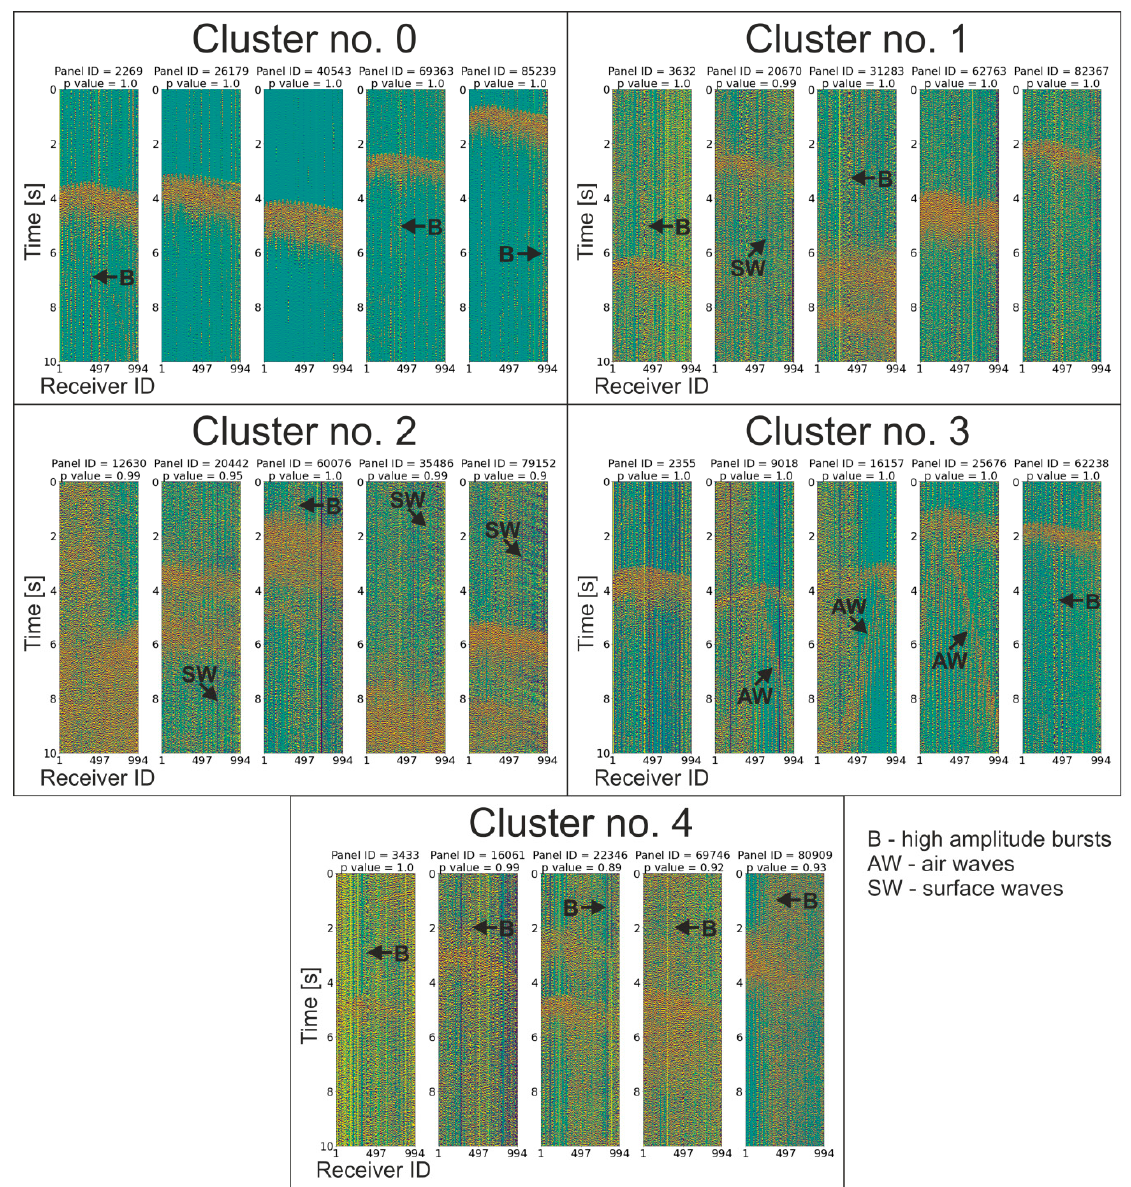
Figure 7. Examples of the body–wave events that are detected by the ensemble of CNN-based models. They are grouped into five image classes according to the clustering results shown in Figure 6b.